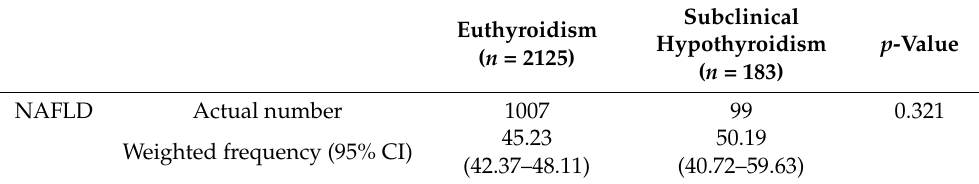
Table 3. Prevalence of NAFLD in participants with euthyroidism and with SCH.